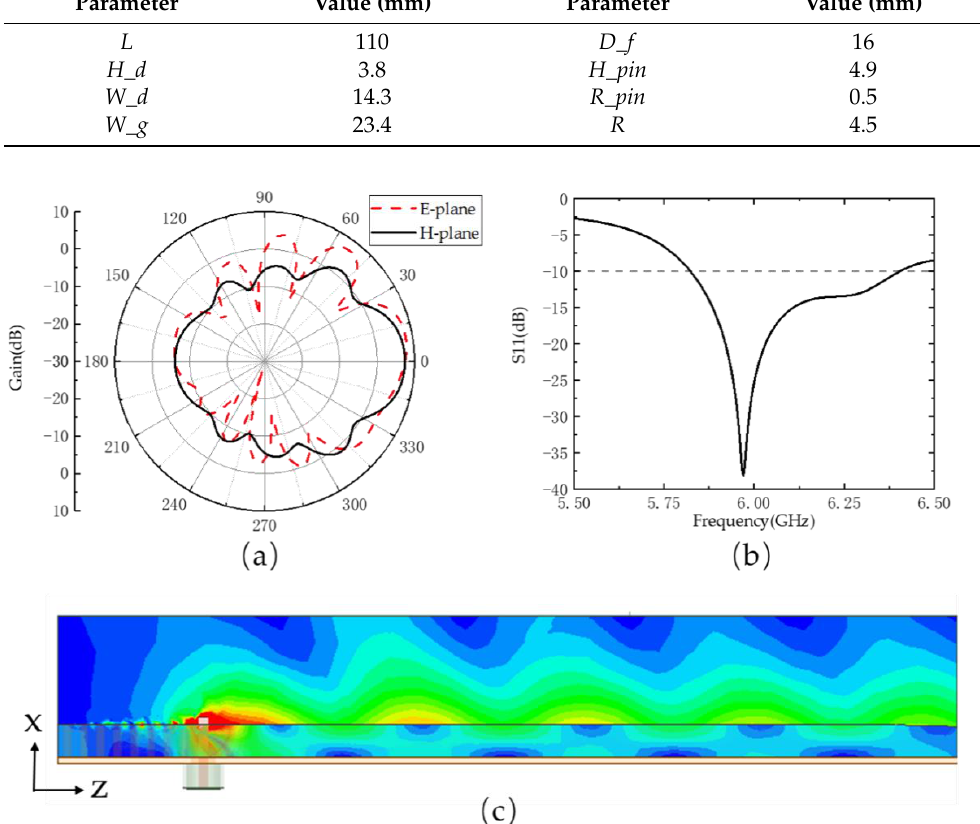
Figure 4. ( a ) Simulated E-plane and H-plane radiation patterns of the element antenna. ( b ) Simu- lated reflection coefficient of the element antenna. ( c ) E-field distribution in the dielectric slab and free space.